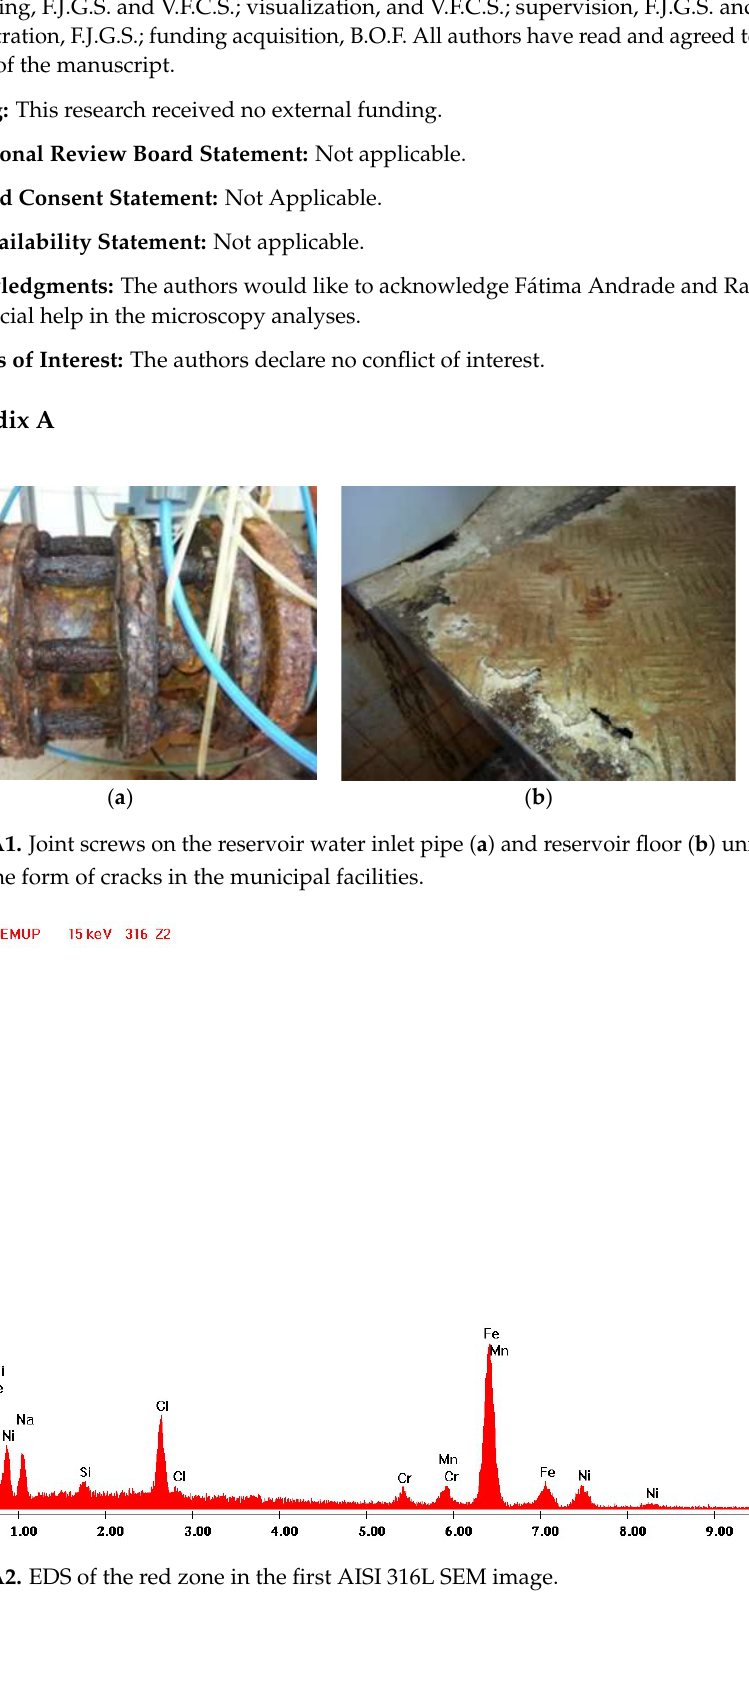
Figure A3. EDS of the red zone in the second AISI 321 SEM image.